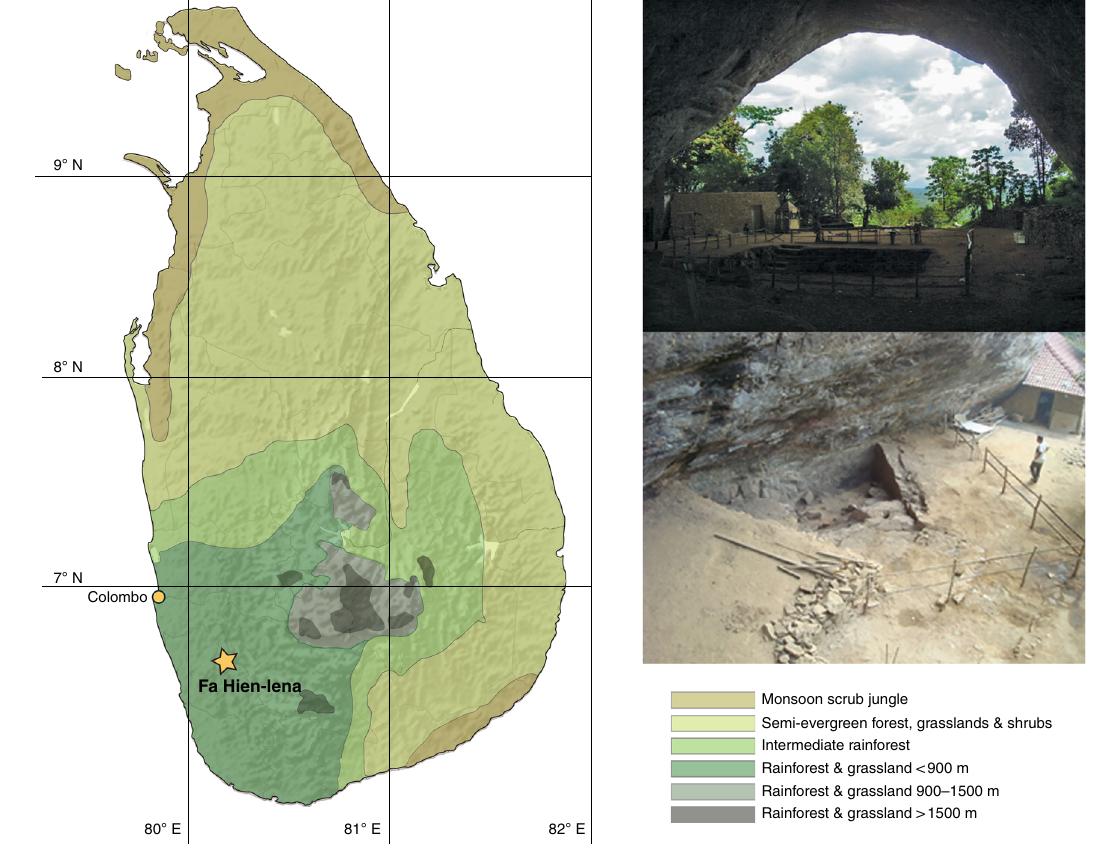
Fig. 1 Location of Fa-Hien Lena. a Map of Sri Lanka showing the location of Fa-Hien Lena and the country ’ s vegetation zones 44,45 . b Excavation in Fa-Hien